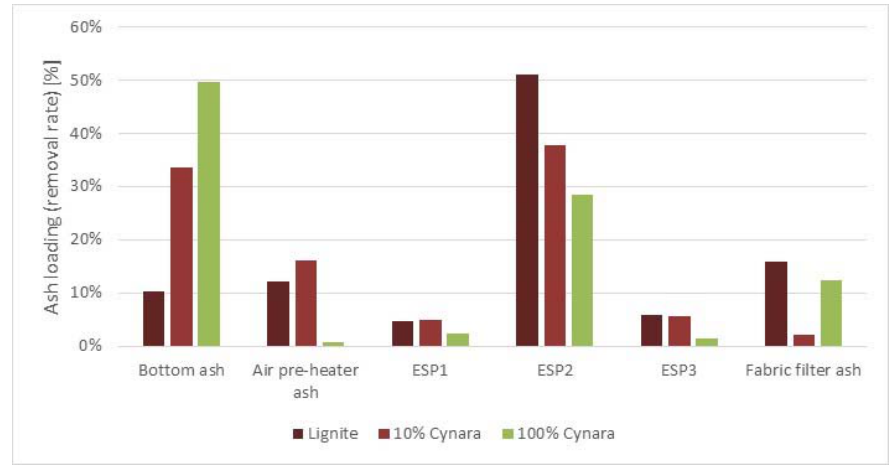
Figure 4. Ash loadings in the furnace and collection points downstream.